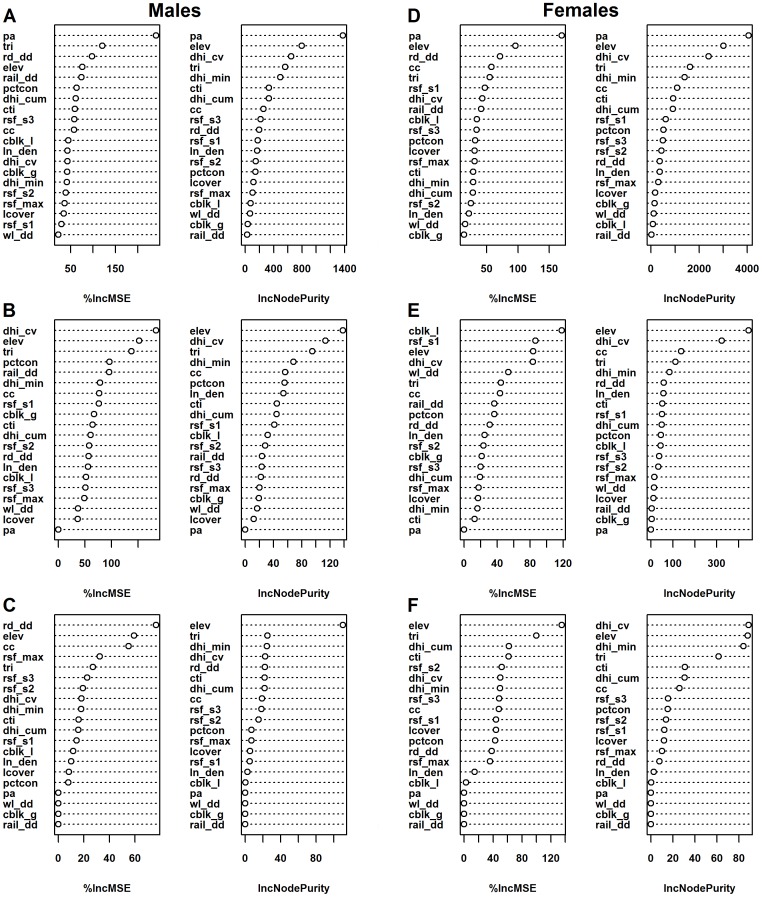
Variable importance metrics for male and female HCC random forest models.Variable importance for the male (A) total model, (B) outside parks and protected areas model, and (C) inside parks and protected areas model, as well as the female (D) total model, (E) outside parks and protected areas model, and (F) inside parks and protected areas model. Variable importance plots on the left of each panel (%IncMSE) represent the accuracy of random forest model predictions based on regression tree splits made using each variable. Plots on the right of each panel (IncNodePurity) indicate how often each variable was used as a split in regression trees aggregated through the random forest. For example, in panels A & D the proportion parks and protected areas was selected often as a tree split in the random forest and had a high predictive HCC value accuracy.